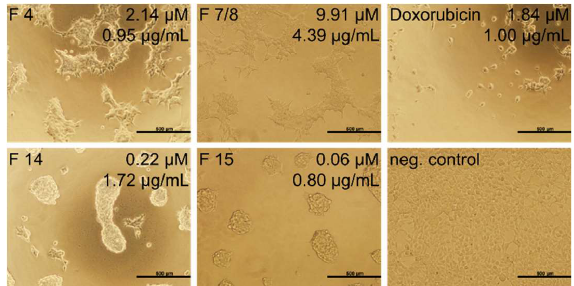
Figure 5. The most active P. flavoviridis venom fraction treatment of SH-SY5Y cells. Single RP-HPLC venom fractions of P. flavoviridis , with the aforementioned mass concentration in μg/mL and molar concentration in μM, were tested against human neuroblastoma SH-SY5Y cells. Images were taken after 48 h of treatment at 37 °C. Doxorubicin was used as a positive cytotoxic control drug and no stimulation as a negative control.